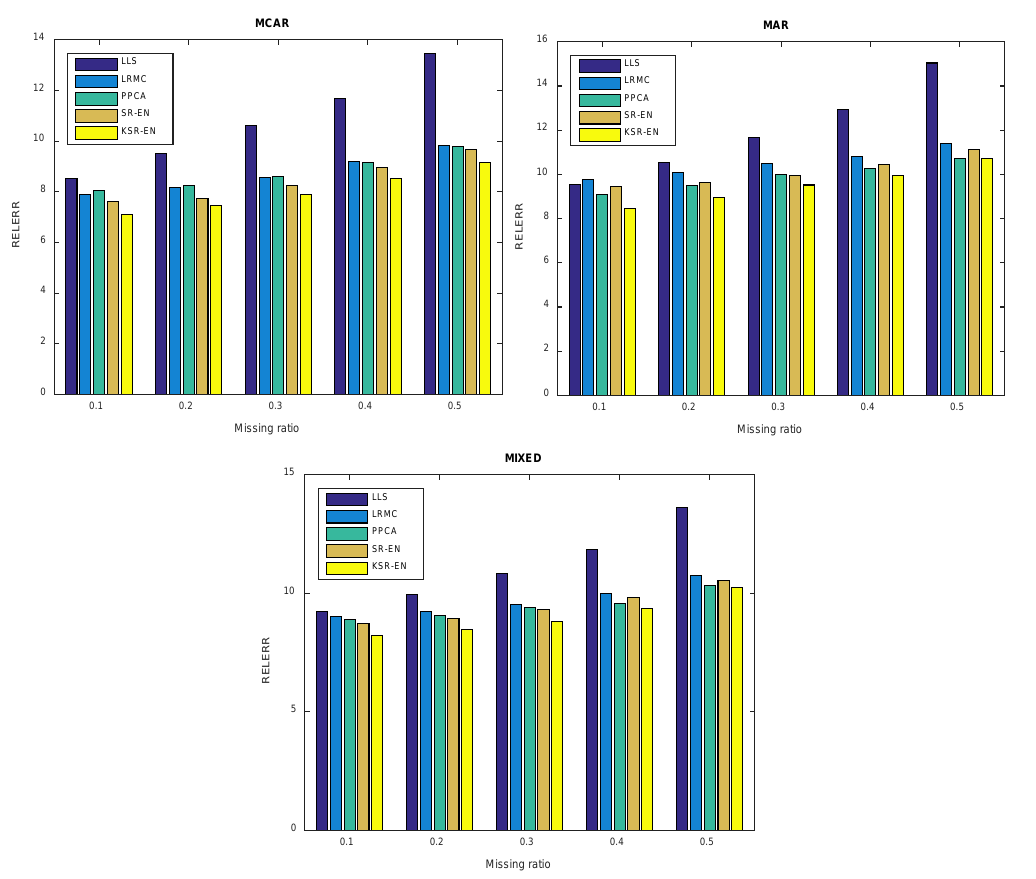
Figure 11. Relative error of each method with 30 min aggregation time.